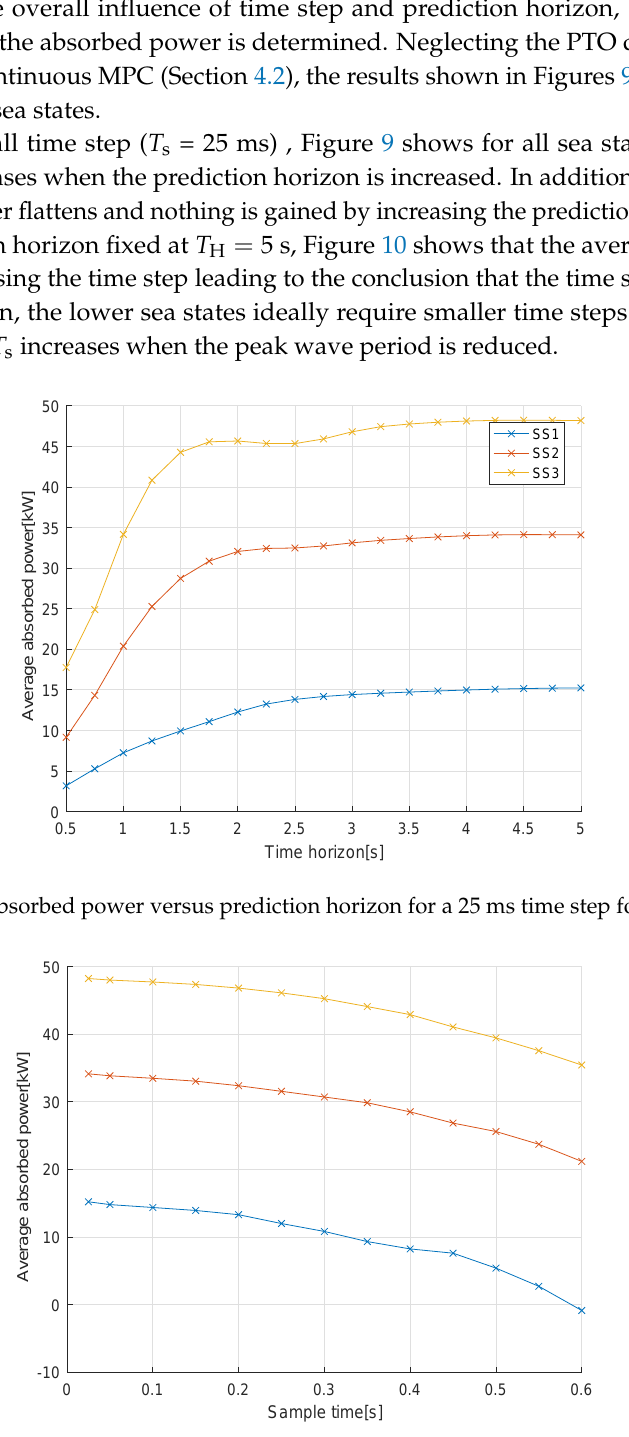
Figure 10. Average absorbed power versus time step for 5 s prediction horizon for three sea states.